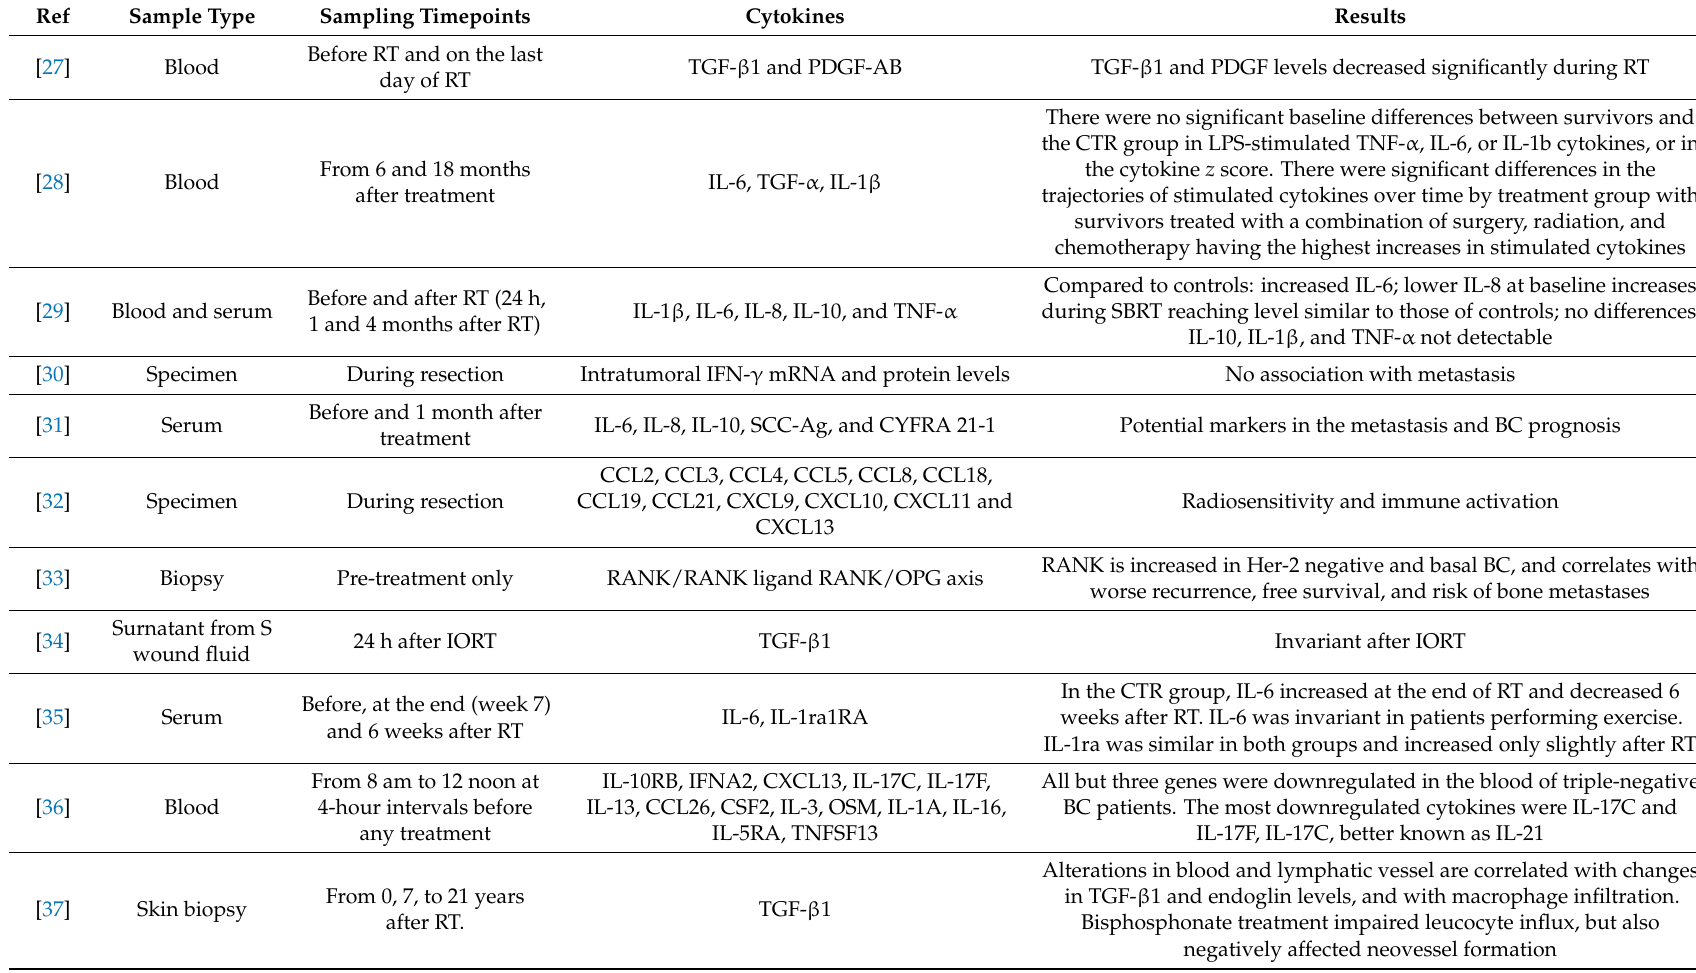
Table 2. Summary of results of the analyzed studies reporting details on sampling types and timepoints, type of cytokines, and main findings. See Table 1 for additional